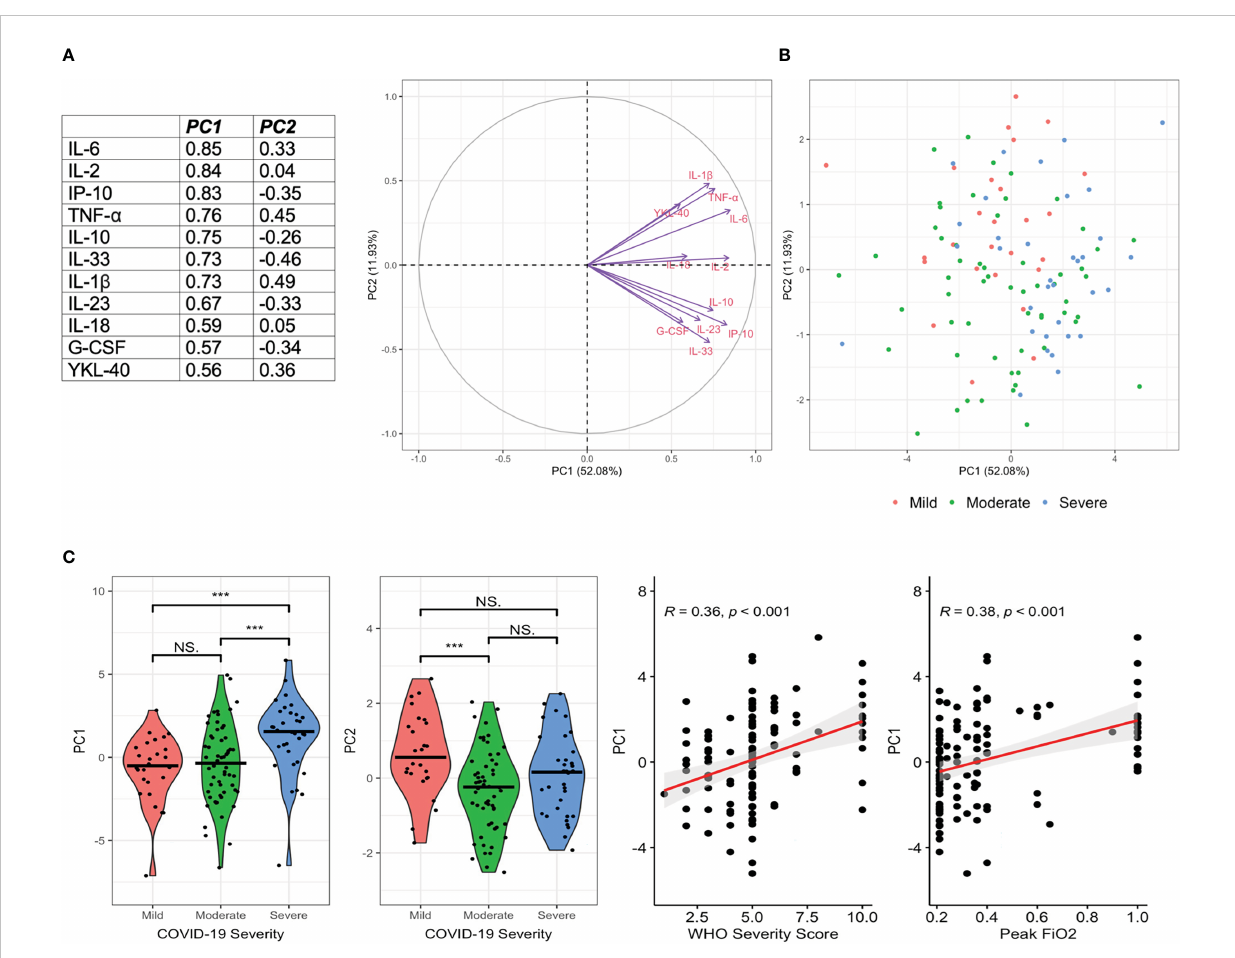
FIGURE 3 Principal Components Analysis Demonstrates a Pro-In fl ammatory Cytokine Signature in Severe COVID-19. Principal Components Analysis (PCA) was performed in those with acute COVID-19 to characterise the variability in in fl ammatory markers within this cohort. 11 markers which differed by disease severity category were included. PC1 and PC2 explained 52.08% and 11.93% of the variance respectively. Markers contributing most to PC1 included IL-1 b , IL-2, IL-6, IL-10, IL-33, G-CSF, TNF- a and IP-10 (A) . Individual PC1 and PC2 values are given by disease severity (B) . PC1 was signi fi cantly higher in severe disease, whilst PC2 was signi fi cantly lower in moderate than mild disease (C) . PC1 was signi fi cantly correlated with WHO Severity Score and increasing oxygen requirements (C) . ***p<0.001, ns, non-signi fi